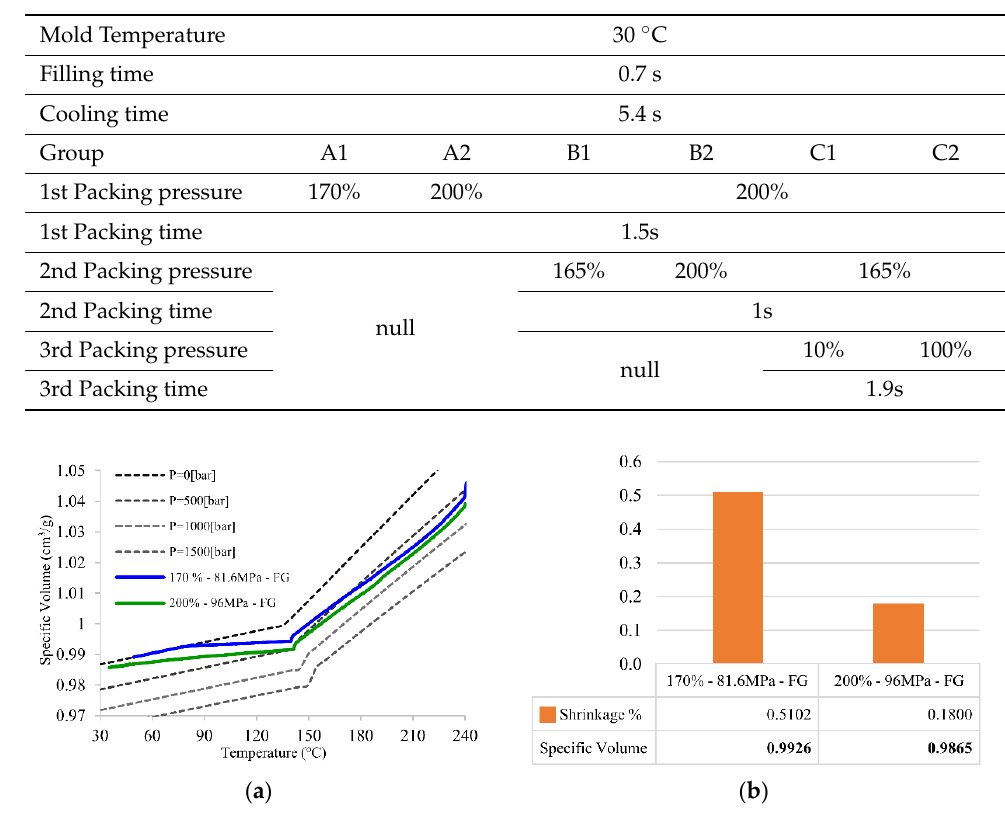
Figure 10. ( a ) PVT processing path of principle of intermittent packing pressure setup and ( b ) the final specific volume and its shrinkage for FG section.